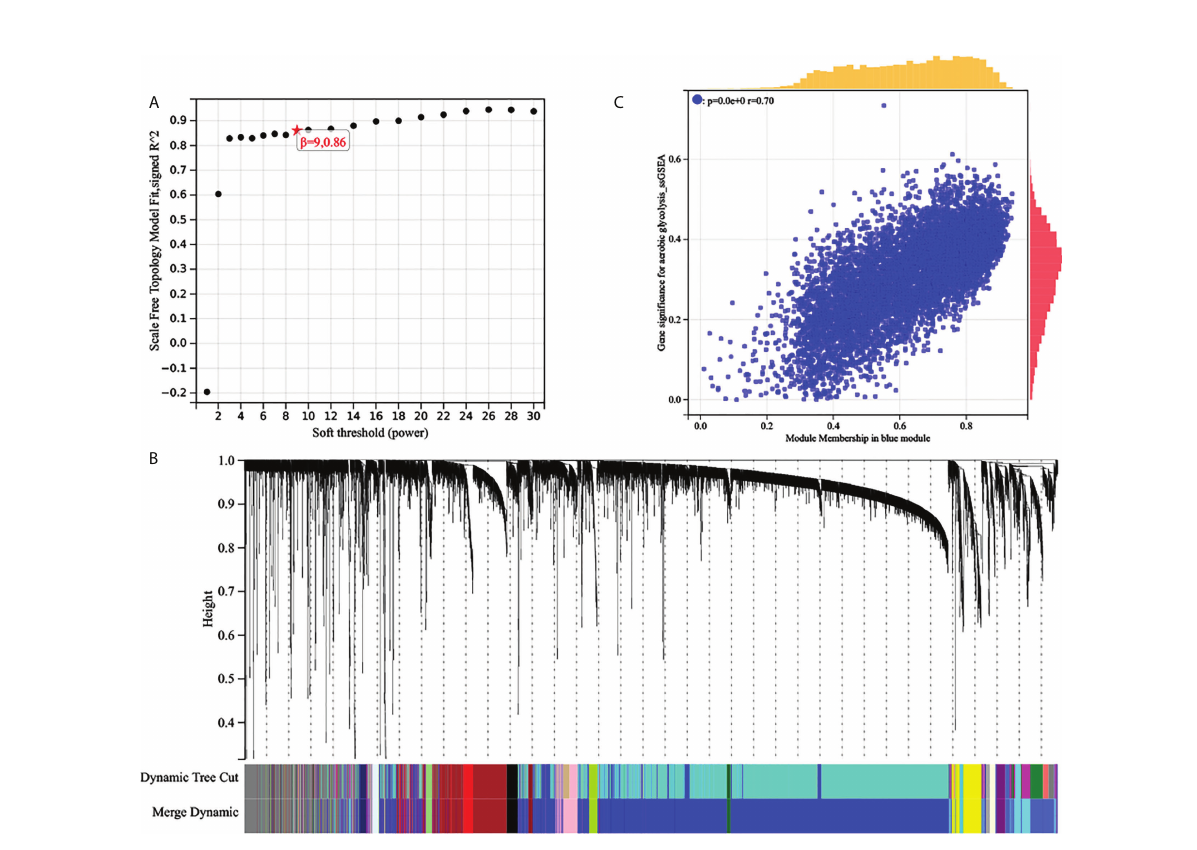
FIGURE 3 (A) Analysis of the scale ‐ free fi t index of the matrix. (B) Clustering dendrograms of top 25% genes, with dissimilarity based on topological overlap, together with assigned module colors. (C) Scatter plots of the gene signi fi cance and module membership in blue modules. The x-axis indicates the module membership (MM) which quanti fi es how close a gene is to a given module. The y-axis indicates the gene signi fi cance which is correlated with clinical